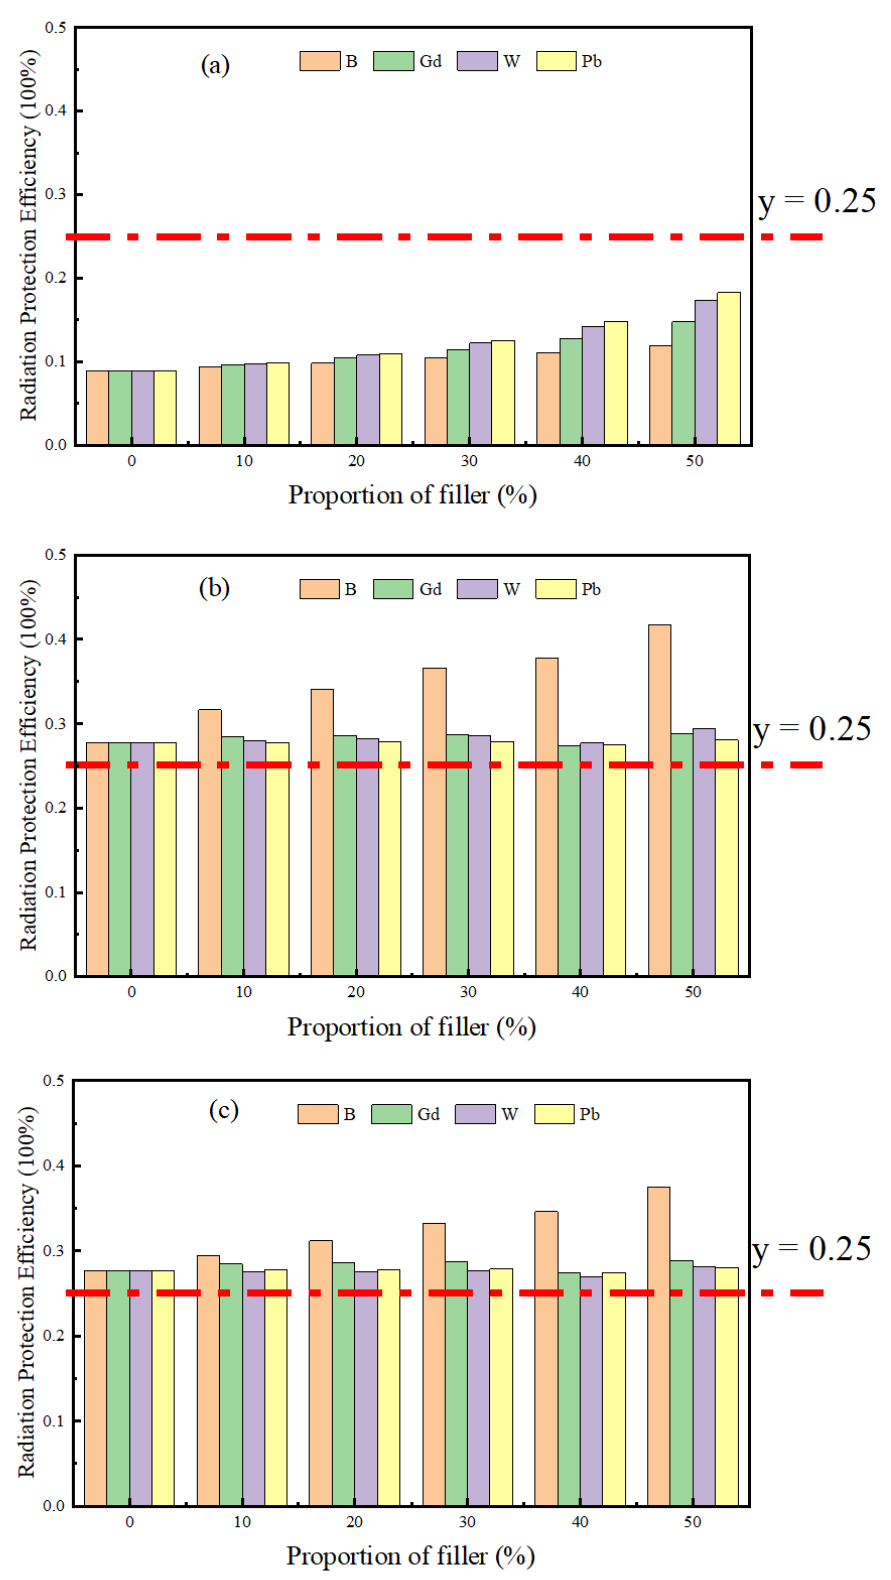
Figure 5. The radiation protection efficiency ( RPE ) of different proportions of functional filler/polyethylene in three radiation fields: ( a ) gamma radiation field; ( b ) neutron radiation field; ( c ) neutron gamma mixed radiation field.